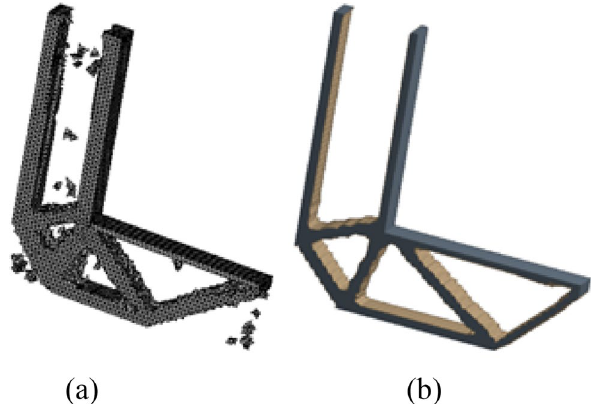
Figure 5. Comparison of optimization results with different optimization algorithms. ( a ) HCAM optimization result ( b ) FEM optimization result.